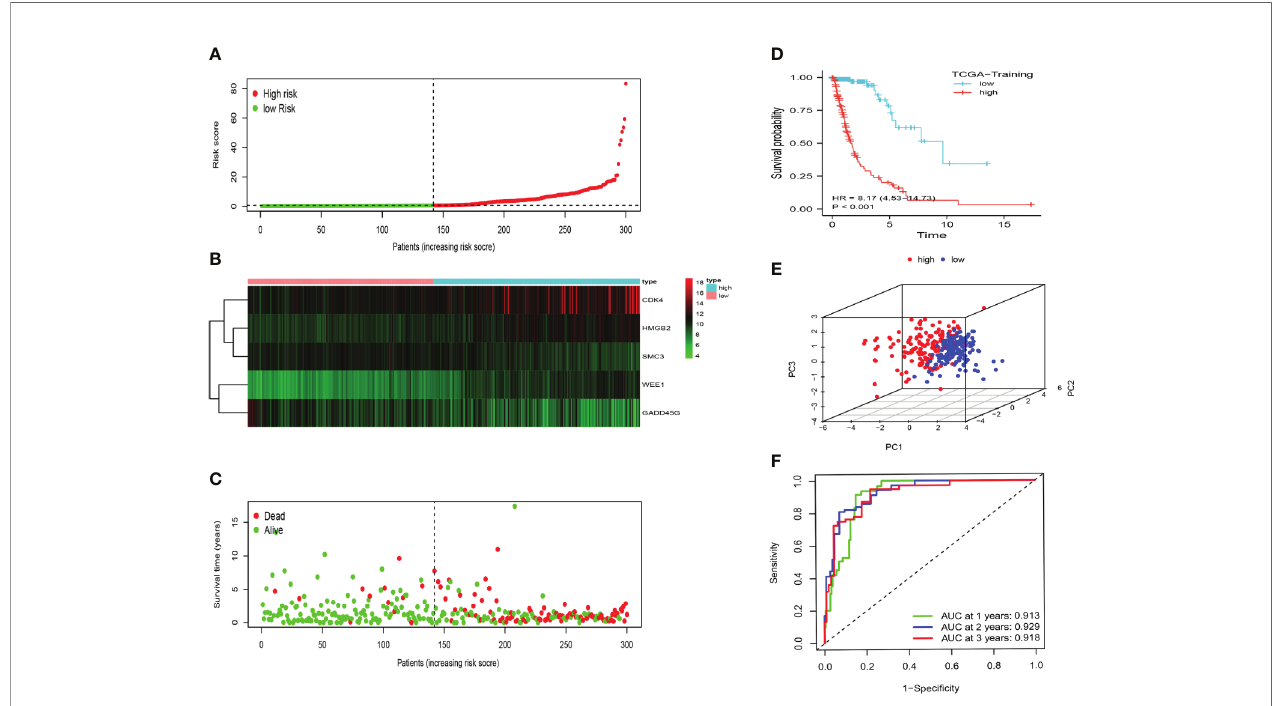
FIGURE 3 | Prognostic analysis of the DDRG signature in TCGA training set. (A) The distribution and median value of the risk scores in TCGA training dataset. (B) The distributions of status, OS, and risk score in TCGA training dataset. (C) Heatmap showing the expression of fi ve genes in the low- and high-risk groups. (D) Survival curve was used to analyze OS of the low- and high-risk groups in TCGA training dataset. (E) Principal components analysis (PCA) of the DDRGs signature. (F) The AUC values of time-dependent ROC curves verify the prognostic performance of the risk score in TCGA training dataset. AUC, area under the curve; DDRGs, DNA damage repair genes; OS, overall survival; ROC, receiver operating characteristic; TCGA, The Cancer Genome